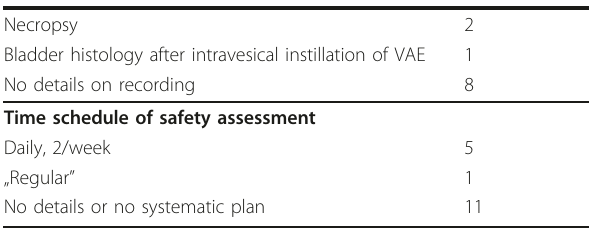
Table 3 Characteristics of the animal experiments (n =